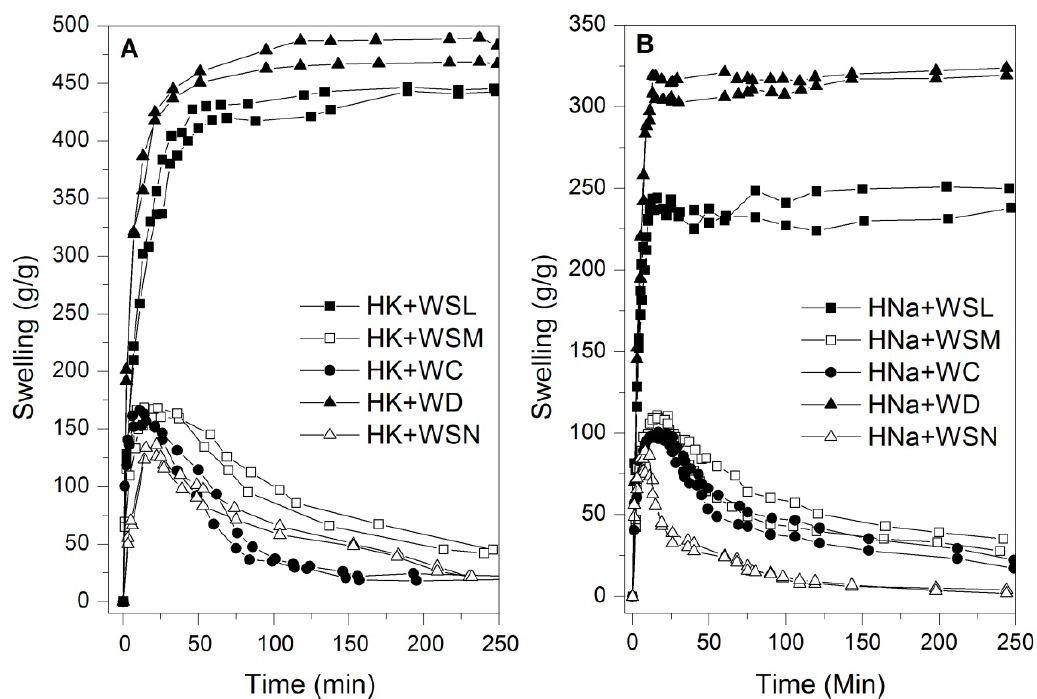
Figure 1. Swelling kinetics of hydrogels in types of waters. ( A ) HK and ( B ) HNa.